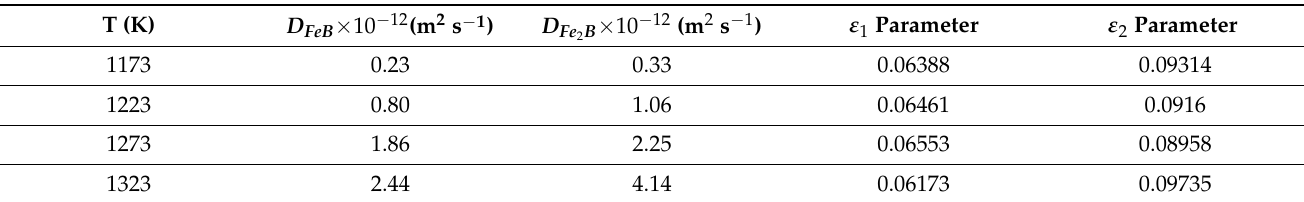
Table 3. Calculated boron diffusivities in FeB and Fe 2 B and the non-dimensional parameters with the integral method for a maximum boron content of 16.40 wt.% in FeB .